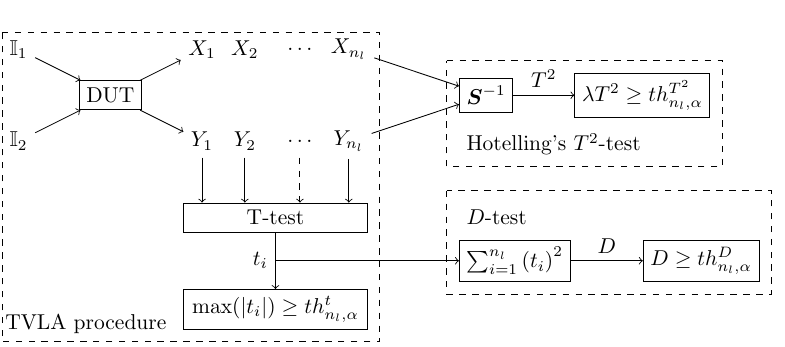
Figure 1: Leakage detection